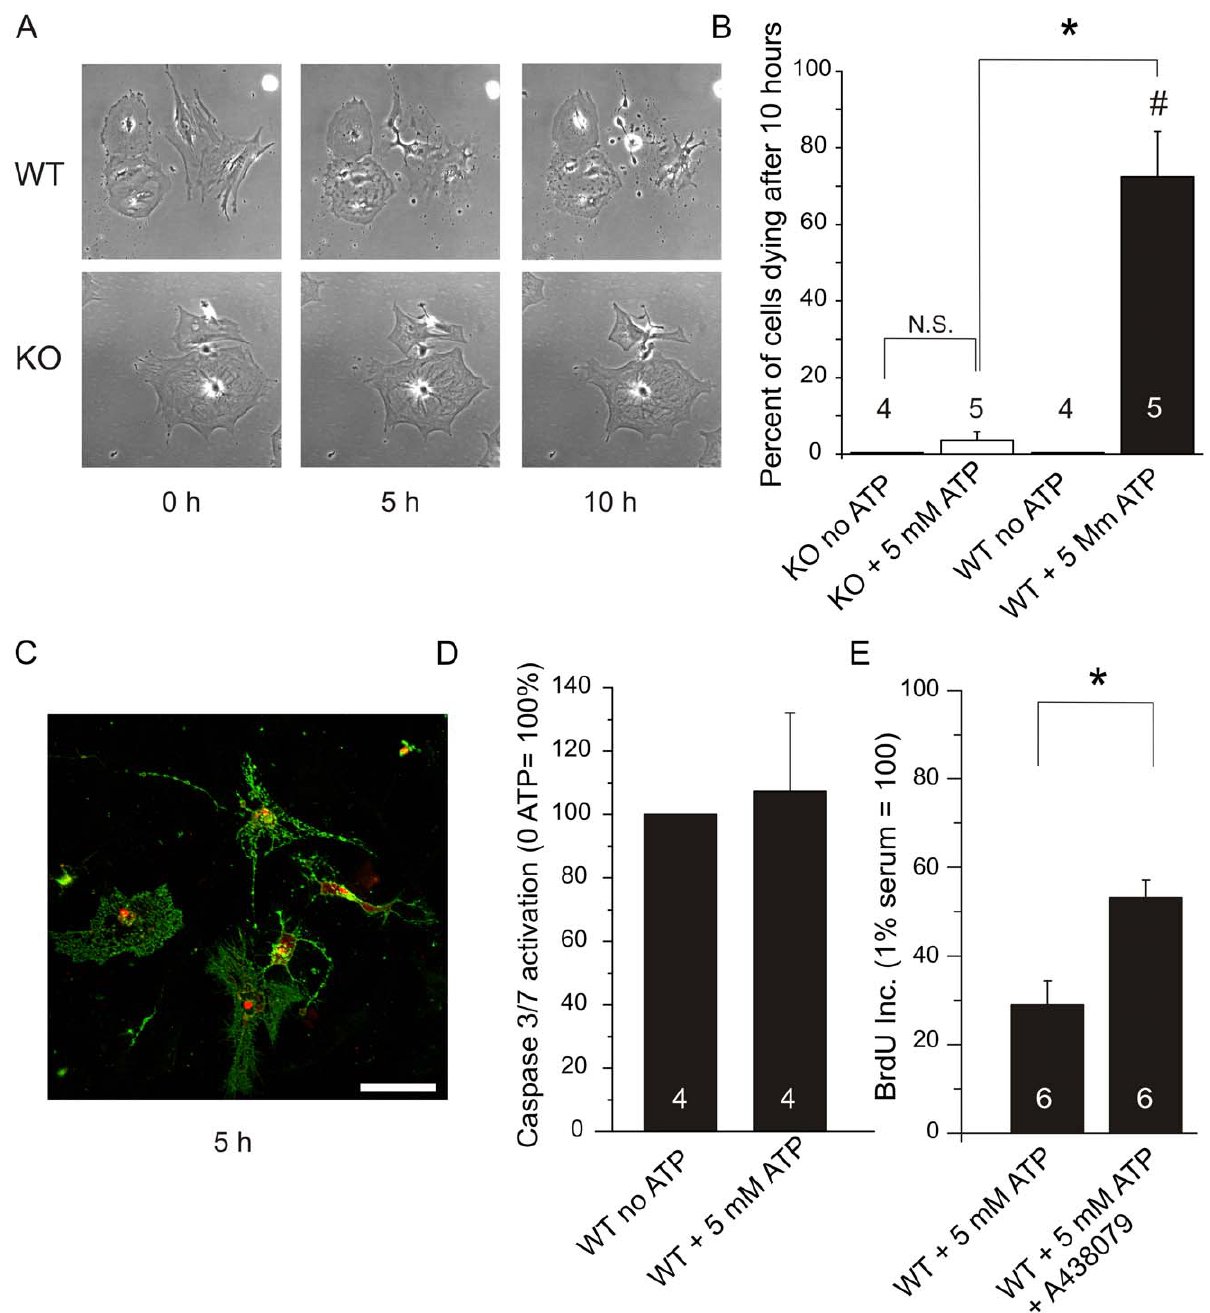
Figure 4. Cell death of PSCs in the presence of 5 mM ATP. A. Behavior of PSCs isolated from WT and KO was monitored for 10 hours; and pictures were taken at 2 min intervals. A. Representative phase contrast images of the PSCs at 0 hours, 5 hours and 10 hours. The top lane are WT cells and the bottom lane are KO cells. B. The bar graph summarizes the number of cells that died in control conditions or after addition of 5 mM ATP (n=4–5 independent experiments). C. AnnexinV-FITC and propidium ioidide stain was added 5 hours after addition of 5 mM ATP to WT cells. D. Caspase 3/7 activation 5 hours after cells were stimulated with 5 mM ATP. E. BrdU incorporation measured 48 hours after the addition of 5 mM ATP. BrdU incorporations were normalized to 1% serum conditions. Significant difference (P , 0.05) from respective controls ( # ) and between WT and KO (*) is indicated. doi:10.1371/journal.pone.0051164.g004 DNA synthesis significantly at 1 mM (72 6 14%, n =17). At 5 mM ATP, the DNA synthesis was greatly reduced (29 6 5%, n= 6) (Fig. 7A). Also the cell number was reduced, as confirmed by cell counting (data not shown).